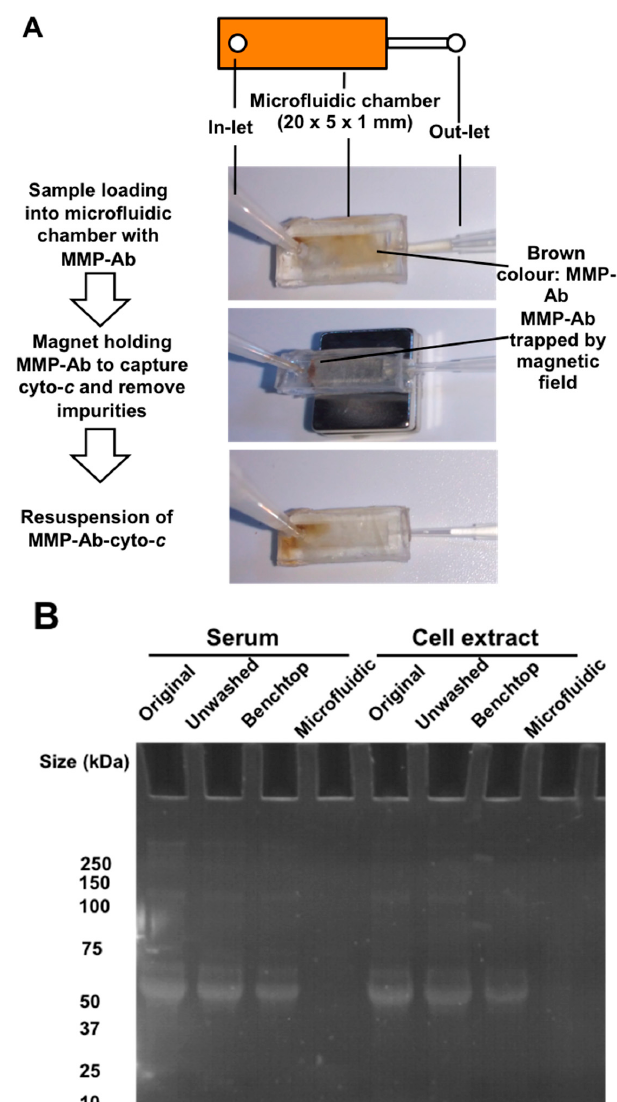
Figure 2. Use of a microfluidic chip to improve impurities removal. A schematic diagram and photos show the microfluidic chip with a reaction chamber in the dimension of 20 × 5 × 1 mm for holding MMPs during the fluidic flow under a fixed magnetic field ( A ). The gel photo shows a comparison of impurities removal between benchtop and microfluidic chip methods during cytochrome- c selection in serum and culture medium ( B